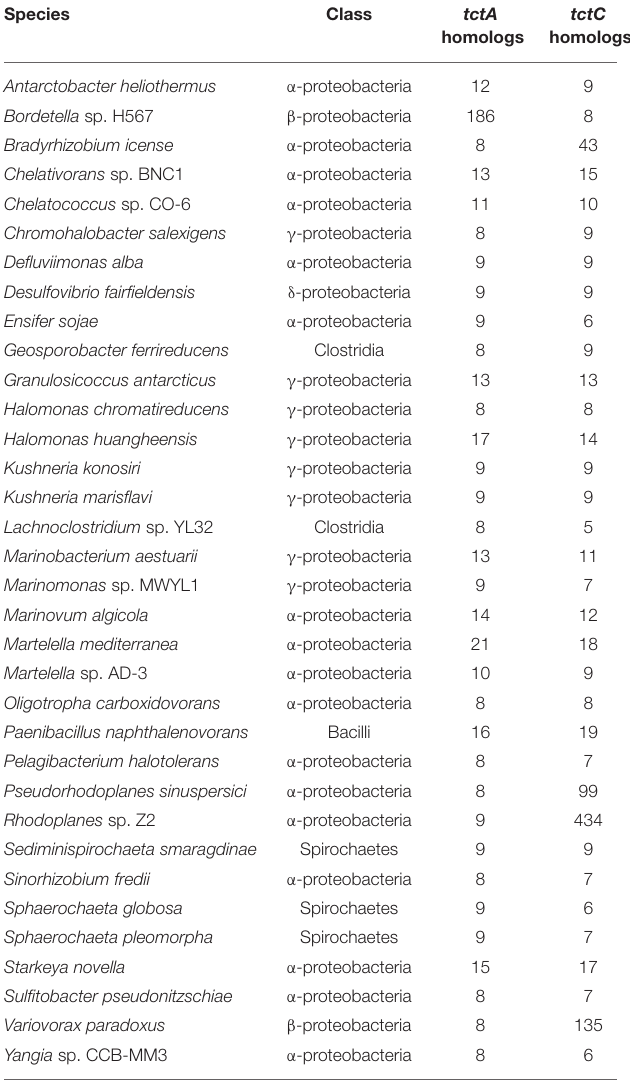
TABLE 4 | Number of TctC and TctA homolog per accession.